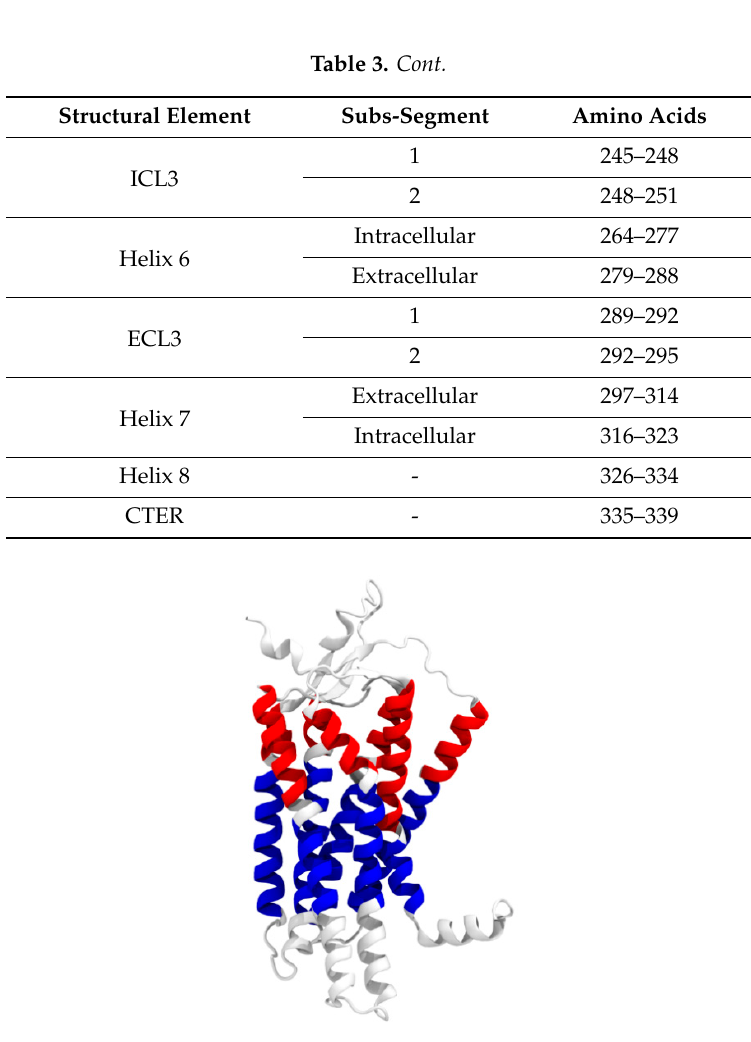
Figure 6. Visualization of the individual extracellular (red) and intracellular (blue) helix segments. Table 3. Summary of the amino acids that comprise the individual segments used in the analysis of the MD simulations.